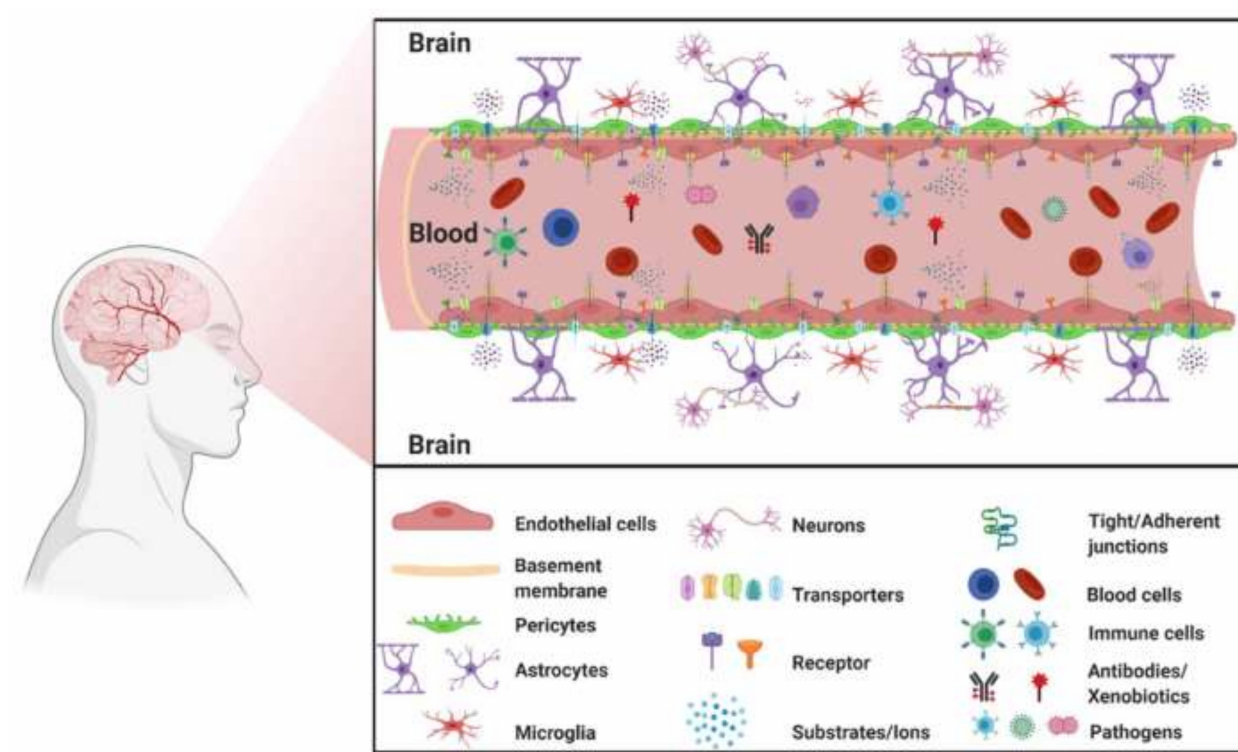
Figure 1. The blood–brain barrier elements. Reprinted from Ref. [14], MDPI,